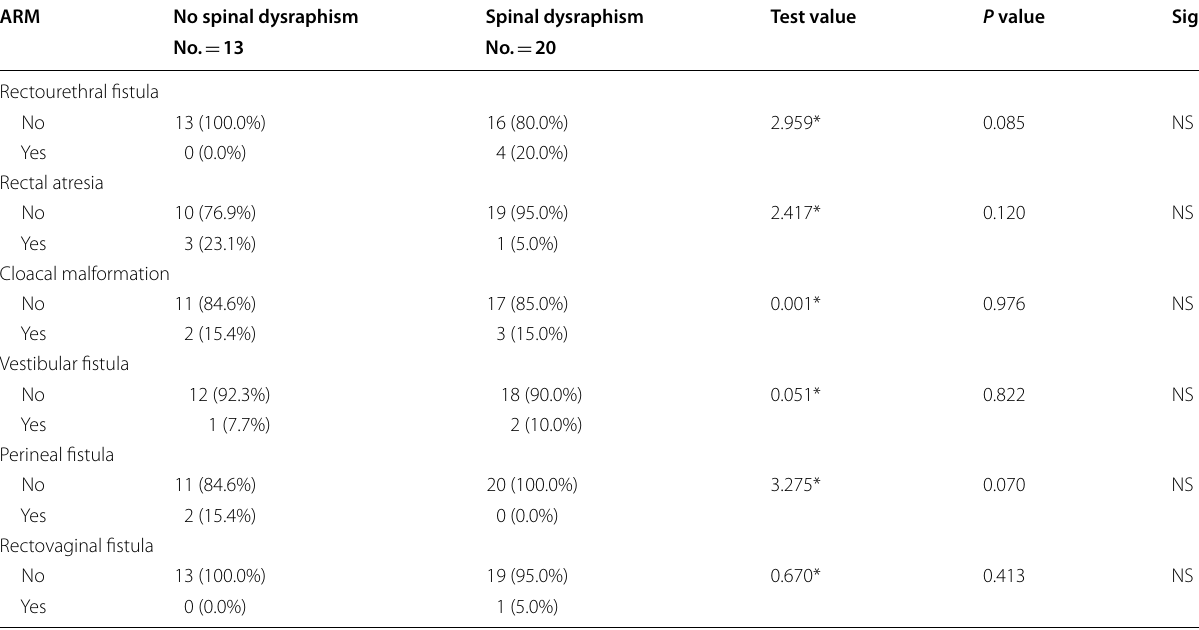
P value > 0.05: non significant; P value < 0.05: significant; P value < 0.01: highly significant *Chi-square